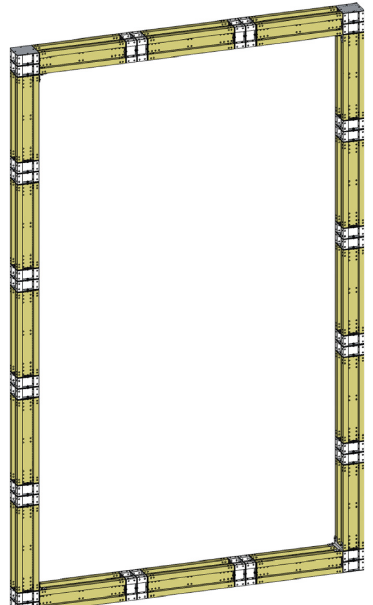
Figure 14: Frame F18M; span 1680mm; modular coordination dimension: